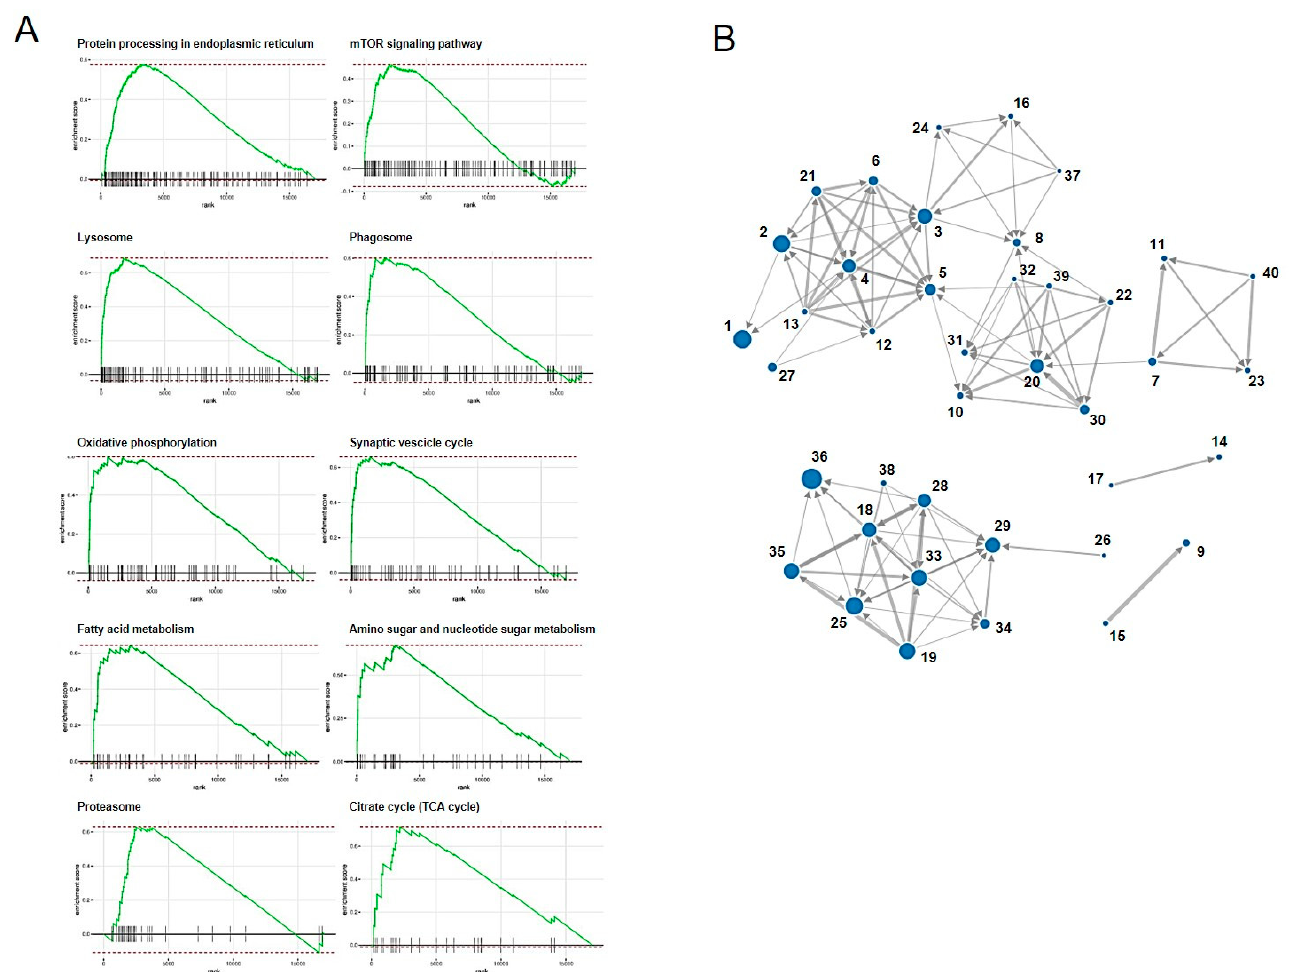
Figure 10. Top 10 RUG plots of the pathways ( A ) and network functions ( B ).